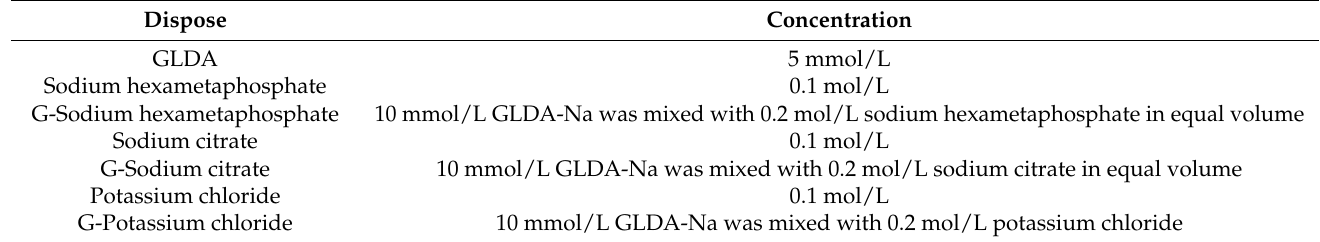
Table 2. Combination of GLDA and different